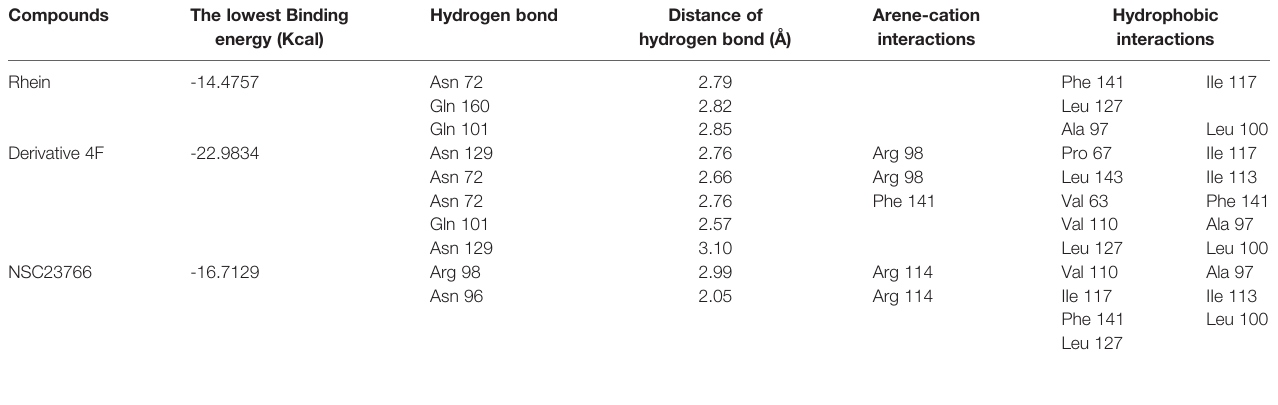
TABLE 1 | ASE function score and molecular force of compounds docked with Rac1. Compounds The lowest Binding energy (Kcal)